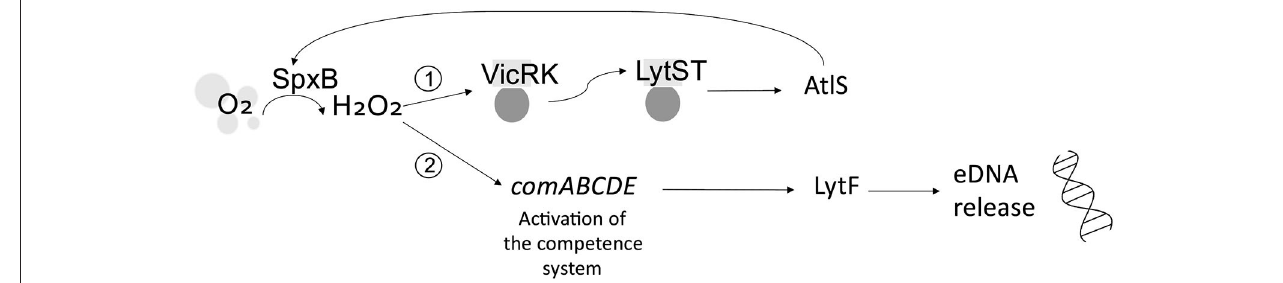
FIGURE 2 | Possible mechanisms of eDNA release from Streptococcus gordonii . Under aerobic conditions, pyruvate oxidase (SpxB) converts oxygen (O 2 ) to hydrogen peroxide (H 2 O 2 ). (1) Indirect: H 2 O 2 induces TCS VicRK, which, in turn, induces TCS LytST and activation of autolysin AtlS, which feeds back to modulate SpxB and the H 2 O 2 -dependent activity of a second pathway. (2) Direct: H 2 O 2 induces the competence system ( comABCDE ), mediating activation of LytF and resultant eDNA release.